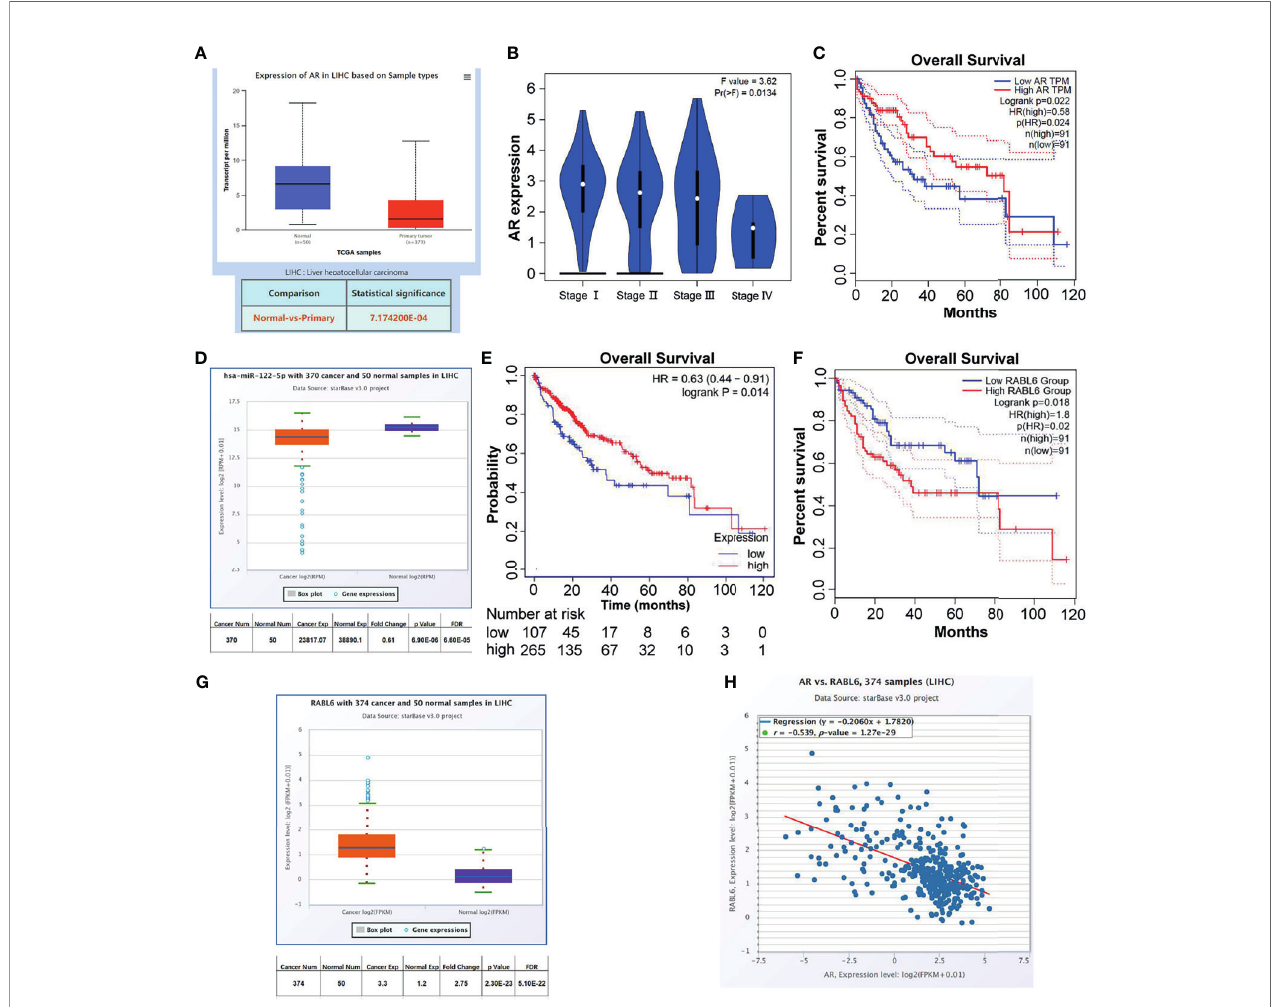
FIGURE 5 | Clinical data to con fi rm the clinical signi fi cance of AR/miR-122-5p/RABL6 axis in the progress of HCC. (A) UALCAN database was used to check AR expression in normal tissues and LIHC samples. (B) GEPIA database was used to check AR expression in different stages of LIHC patients. (C) GEPIA database was used to analyze survival of different expression of AR in LIHC patients. (D) ENCORI database was used to check miR-122-5p expression in normal tissues and LIHC samples. (E) Kaplan-Meier Plotter database was used to analyze survival of different expression of miR-122-5p in LIHC patients. (F) GEPIA database was used to analyze survival of different expression of RABL6 in LIHC patients. (G) ENCORI database was used to check RABL6 expression in normal tissues and LIHC samples. (H) ENCORI database was used to analyze the expression correlation between AR and